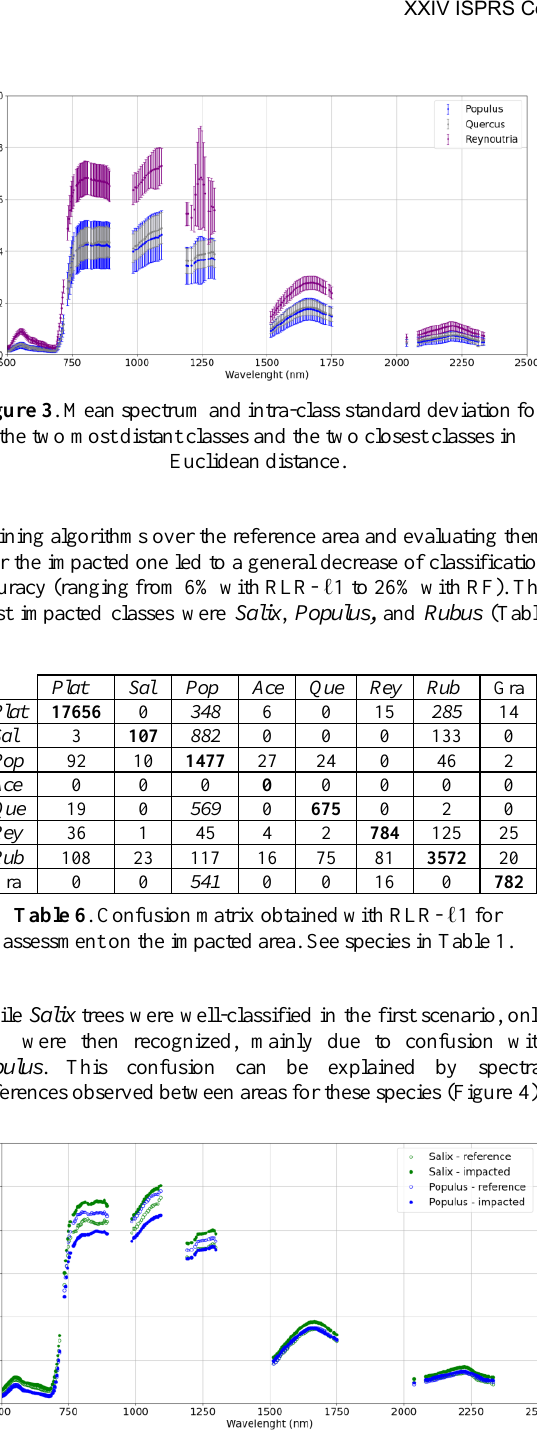
Figure 4 . Mean spectral signatures of Salix and Populus over the reference area (unfilled points) and over the impacted area (filled points).